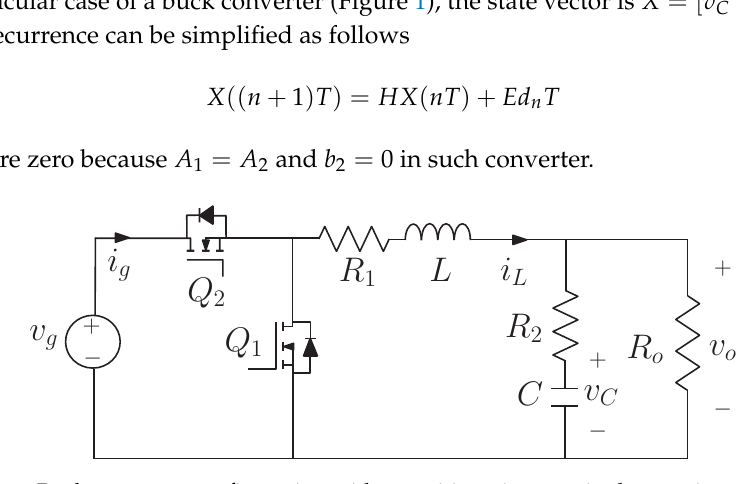
Figure 1. Buck converter configuration with parasitic resistances in the reactive